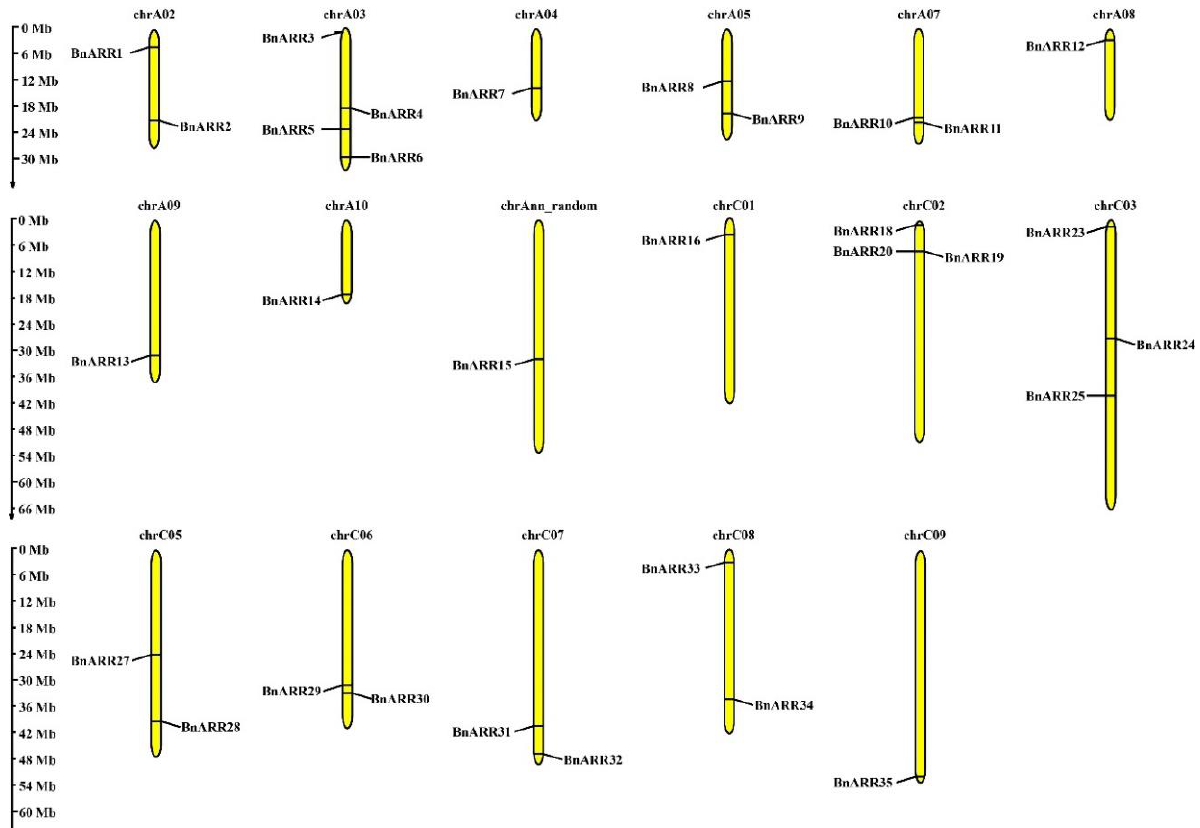
Figure 4. The distribution of type-B ARRs on rapeseed chromosomes. Mb, megabase.